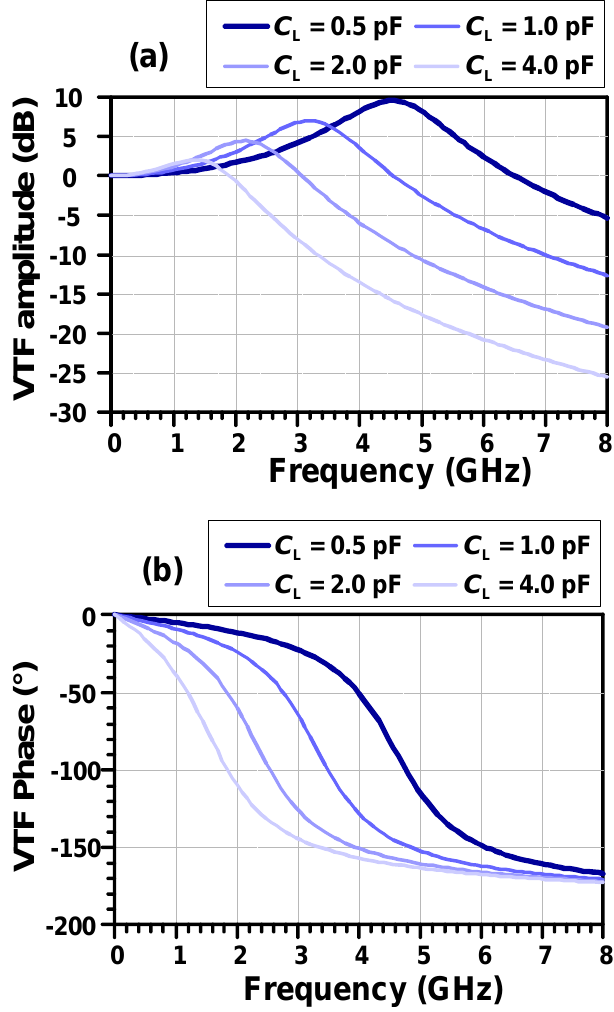
Figure 12: Frequency responses versus load C L for the magnitude (a) and the phase (b) of the VTF for case 2.